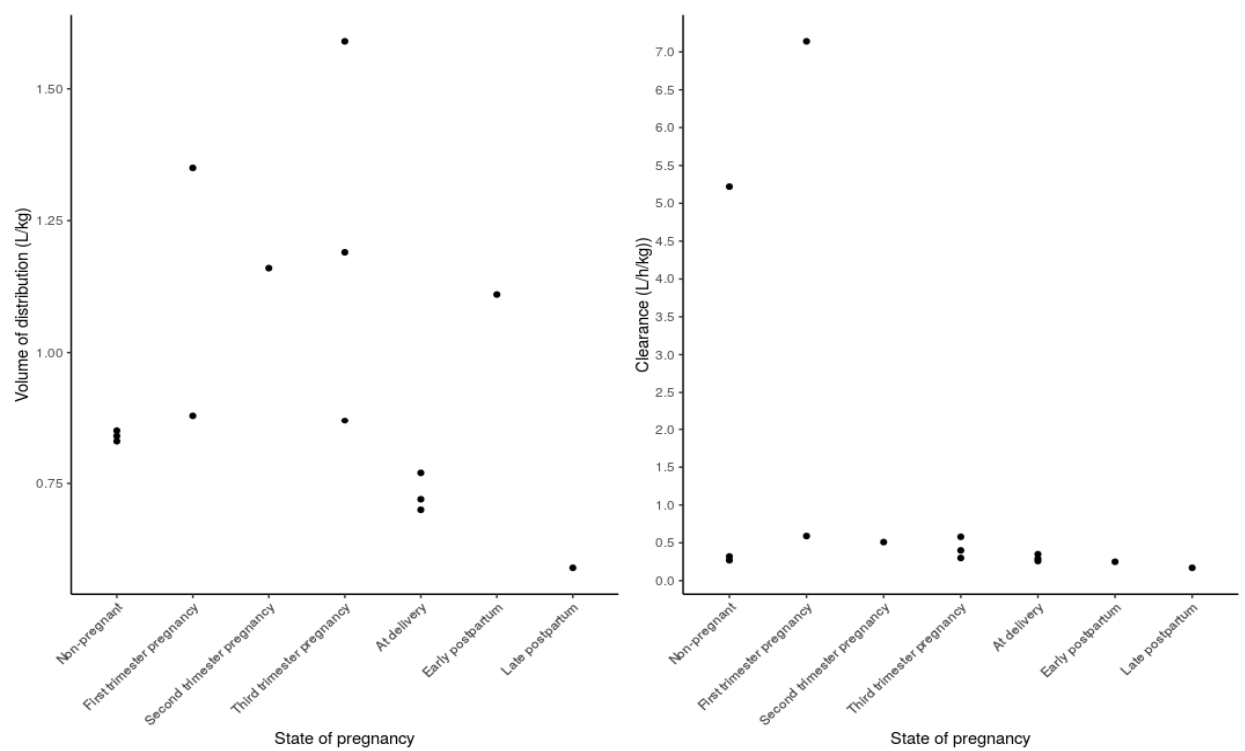
Figure 3. Scatter plots of the measured volume of distribution (expressed in L/kg) and clearance (expressed in L/h/kg) obtained from non-compartmental analysis techniques in non-pregnant women, first-, second- and third-trimester pregnant women, women at delivery, and early and late postpartum women.